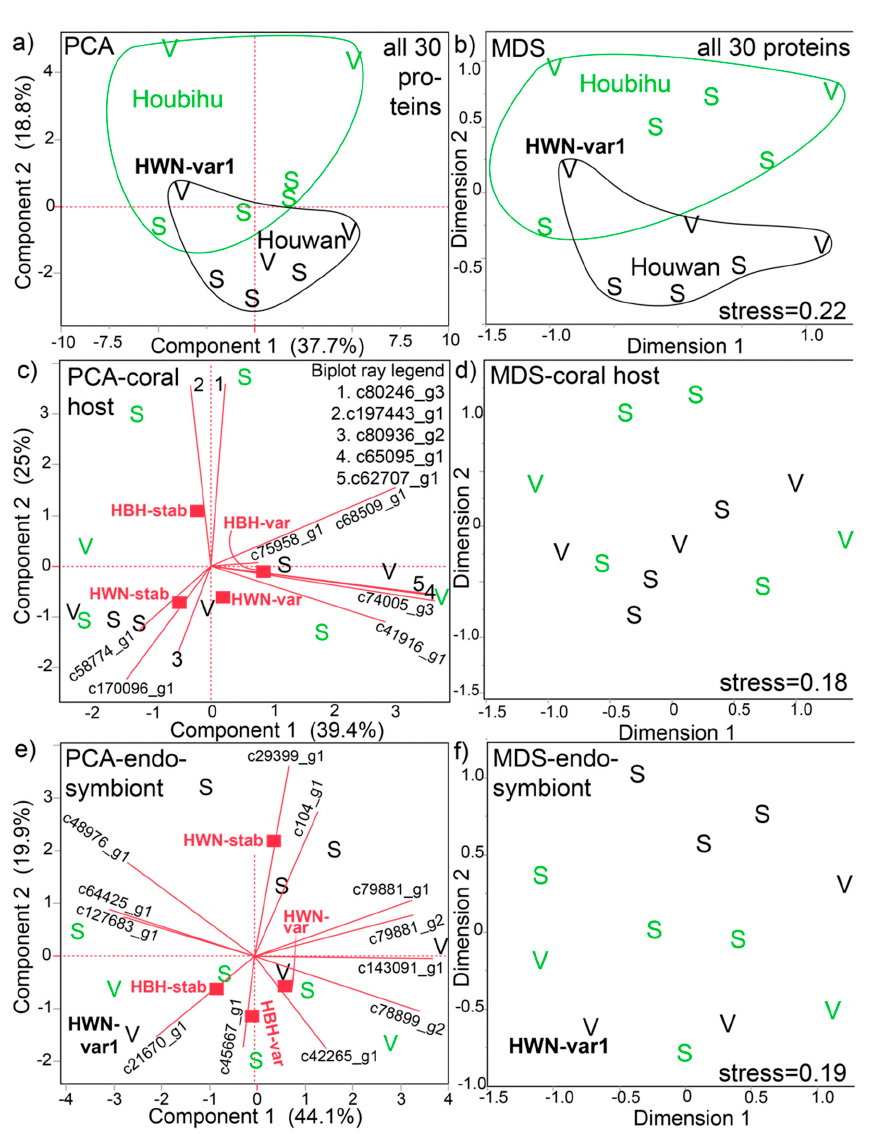
Figure 2. Multivariate analysis of the partial Seriatopora hystrix -Symbiodiniaceae proteome. Both principal components analysis (PCA) on correlations ( a , c , e ) and multi-dimensional scaling (MDS) with standardized data ( b , d , f ) were carried out with all 30 proteins ( a and b , respectively), the 11 host coral proteins only ( c and d , respectively), and the 12 endosymbiont proteins only ( e and f , respectively). In panel a , samples from each site of origin, Houbihu (HBH; green icons and lines) and Houwan (HWN; black icons and lines), have been grouped by their k-means cluster; one HWN sample, HWN-var1, that fell within the HBH cluster has been labeled for emphasis in this panel, as well as certain others. The ellipses in panel b were, in contrast, drawn by eye and do not signify clustering. Certain biplot rays in panel d have been enumerated due to spatial constraints, with the legend found in the top-right corner of the panel. In the compartment-specific PCAs ( c , e ), the mean positions of the four site of origin x temperature treatment interaction groups have been shown as red squares. S = stable temperature samples. V = variable temperature